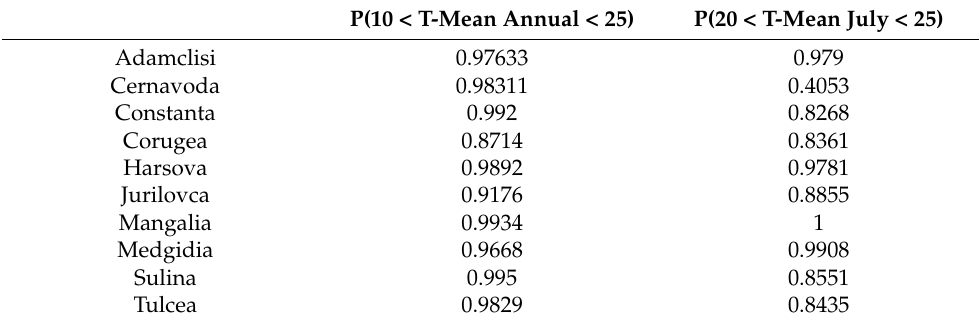
P(10 < T-Mean Annual <